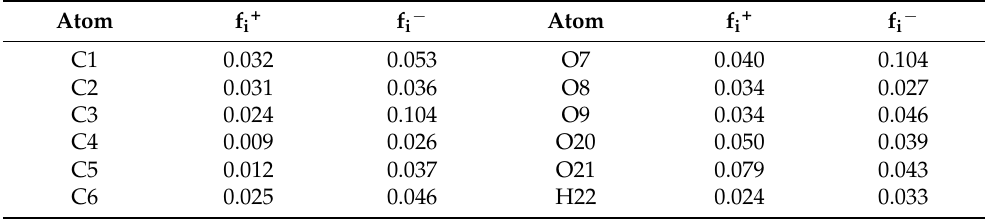
Table 4. Fukui function of